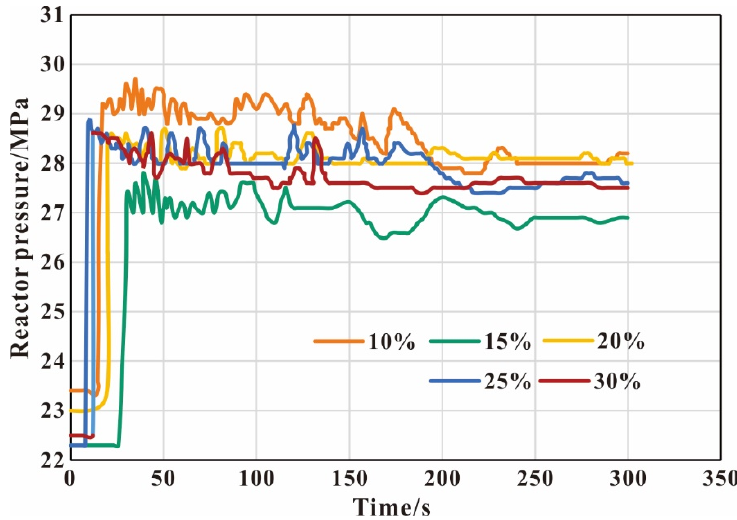
Figure 13. Changes of pressure in the reactor during the supercritical water–crude oil reaction experiment under different oil–water ratios.